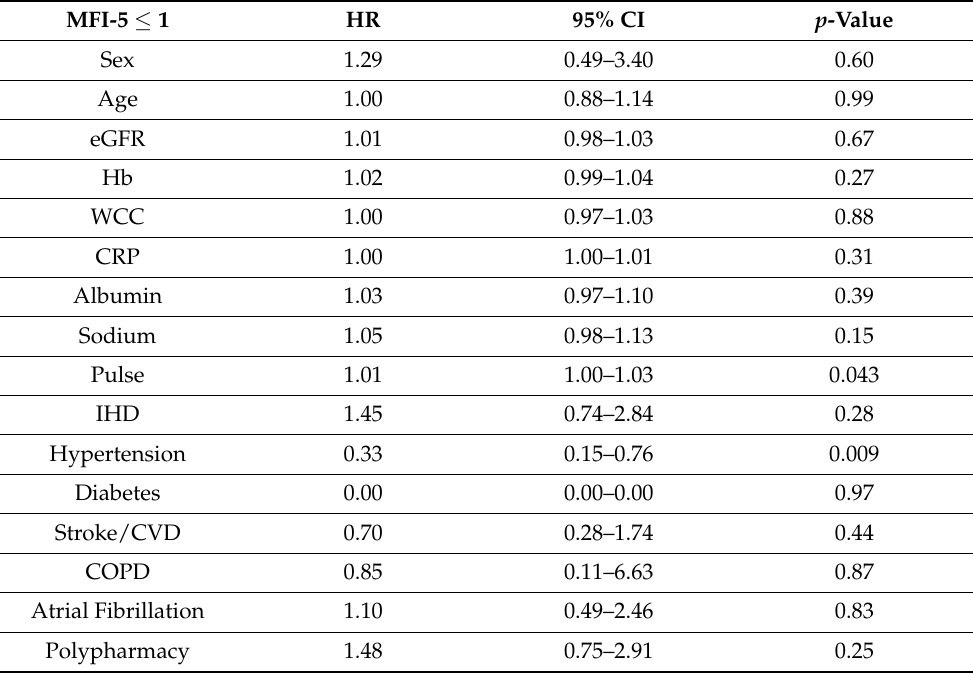
Table 3. Fully adjusted multivariate Cox proportional hazards model for non-frail patients (MFI-5 ≤ 1). MFI-5 ≤ 1